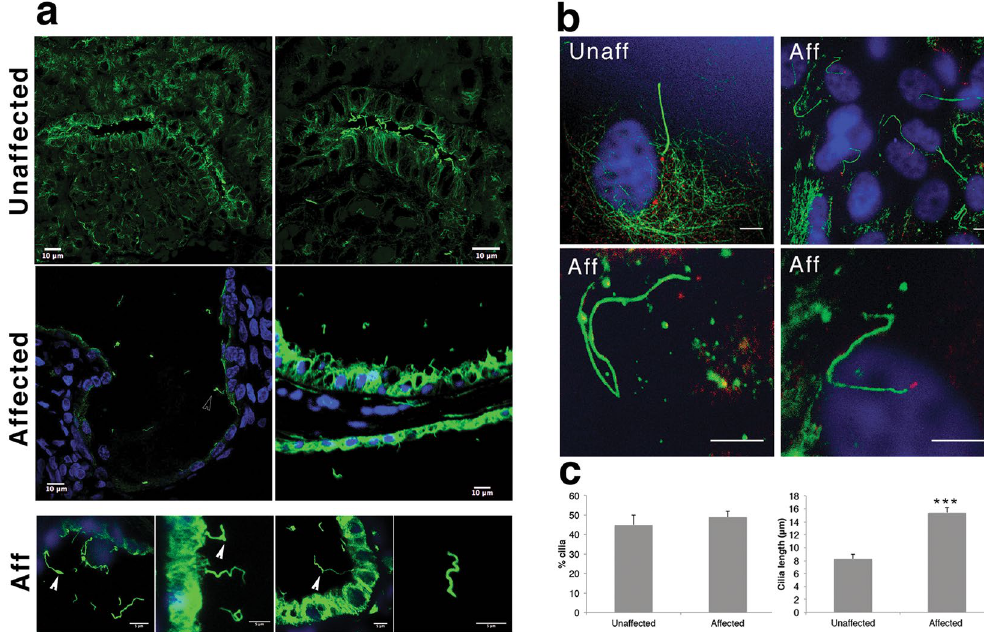
Figure 7. Defects in cilia morphology and length in affected lamb kidneys. ( a ) Acetylated α -tubulin labeling of primary cilia (green) in kidneys from unaffected and affected newborn lambs. Bottom panel (Aff) shows higher magnification images of primary cilia from affected lambs, which displayed a range of abnormal morphologies including bulbous projections along axonemes, sharp kinks and a wide range of lengths. Aceylated α -tubulin- positive structures were also present in the cyst luminal contents. The cell nuclei were stained with DAPI (blue). ( b ) Immunocytofluorescence labeling of primary cilia (acetylated α -tubulin; green) and centrioles (gamma- tubulin; red) in renal interstitial fibroblasts cultured from unaffected (Unaff) newborn lamb kidney, or affected (Aff) newborn lamb kidneys. In unaffected cells, acetylated α -tubulin was present in primary cilia, and gamma- tubulin localised in the two centrioles at the ciliary base. In affected fibroblasts, primary cilia were significantly longer that unaffected cilia and showed similar dymorphologies as observed in situ , including evidence of acute bending, bulbous projections along the axoneme and variably stained centrioles. Cell nuclei are stained with DAPI (blue). ( c ) Graphs of cilia incidence and cilia length measured in renal interstitial fibroblasts cultured from unaffected and affected newborn lamb kidneys (n ≥ 50 cilia per condition, from a total of 31 fields of view). *** p < 0.001. Scale bar = 10 µ